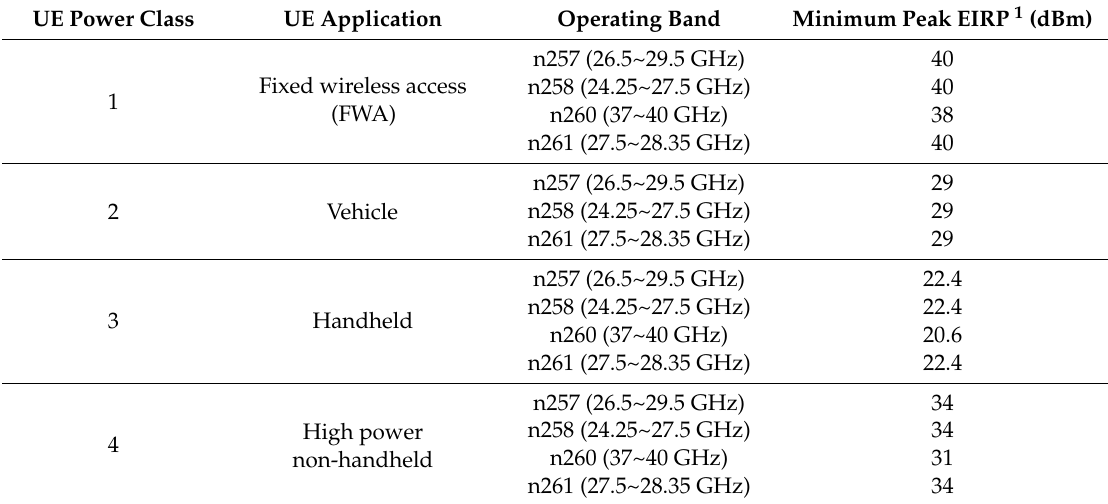
Figure 1. Block diagram of 1 × 4 array antennas and transmitter chains in 5G communication systems. Table 1. User equipment (UE) minimum peak equivalent isotropic radiated power (EIRP) according to power class and operating